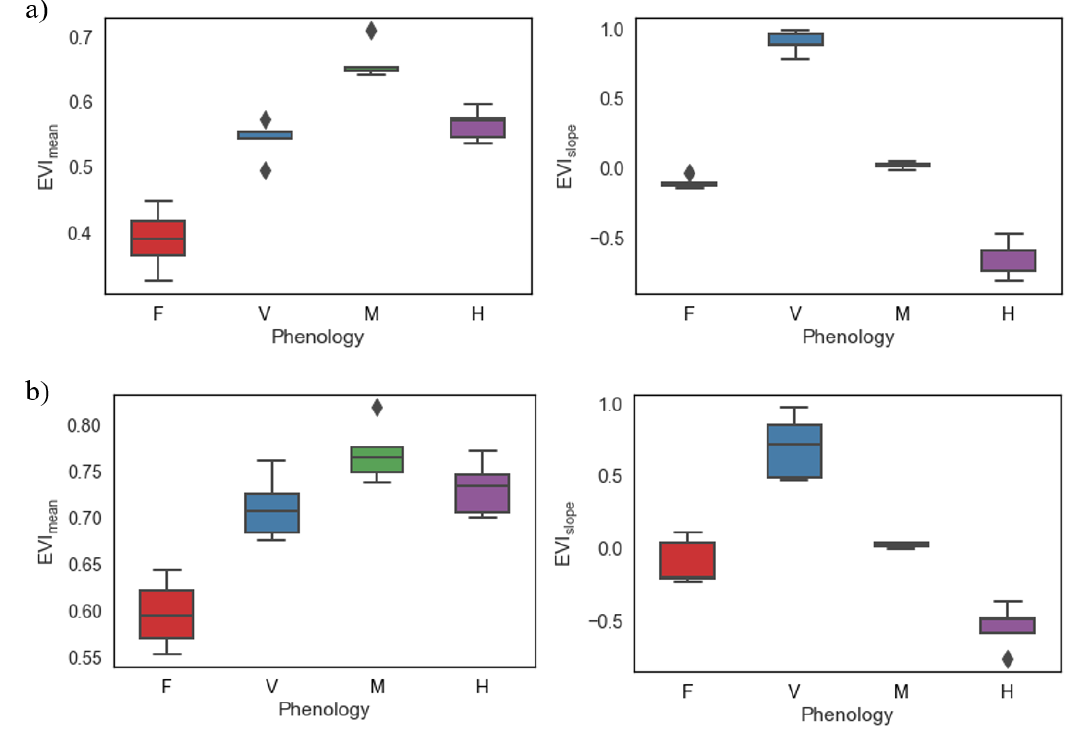
Figure 6. The box plots of EVI mean and EVI slope data showing the differences among the four phenological stages (i.e., F, V, M, and H) for the ( a ) Bundaberg ( n = 5 years) and ( b ) Renmark ( n = 5 years) avocado farms. Table 2. Results of the Tukey-HSD test on the phenological stages for the Bundaberg and Ren- mark